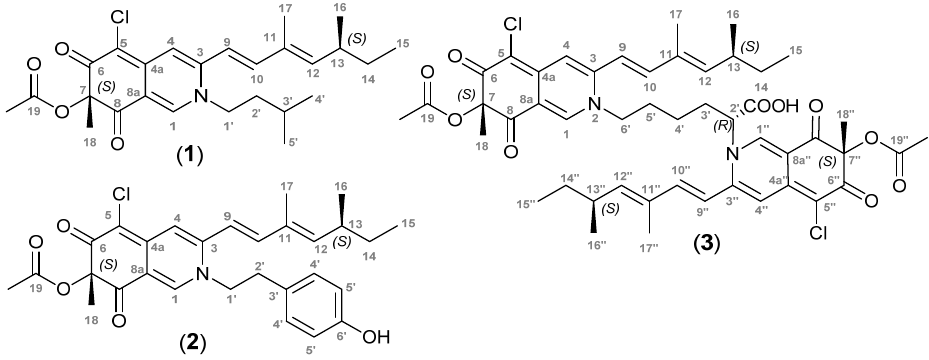
Figure 3. Structures of penazaphilones J – L ( 1 – 3 ).